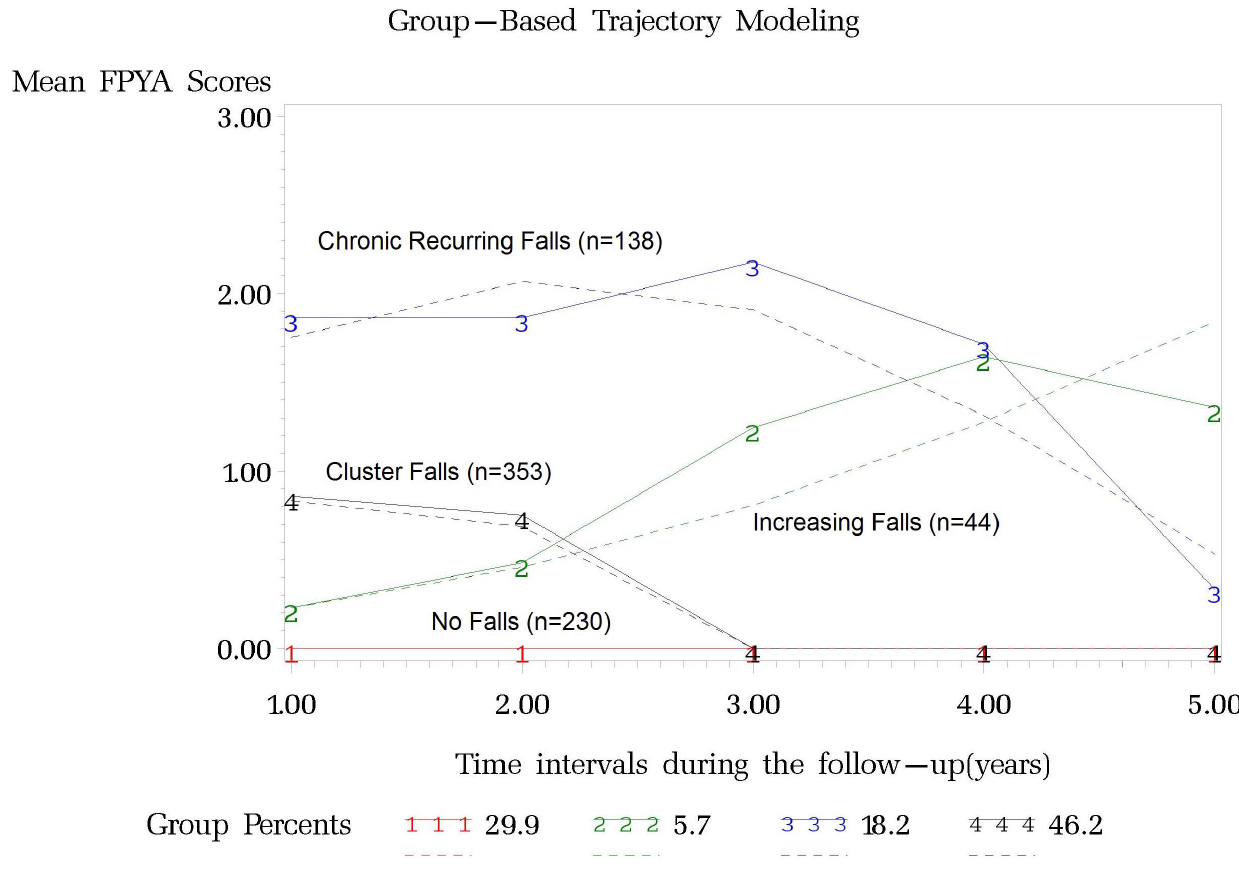
Figure 1. Patterns of Falls Trajectories over 5 years in Older Adults (The MOBILIZE Boston Study). —Solid lines are estimated trajectories. ---- Dashed lines are observed trajectories for each group.